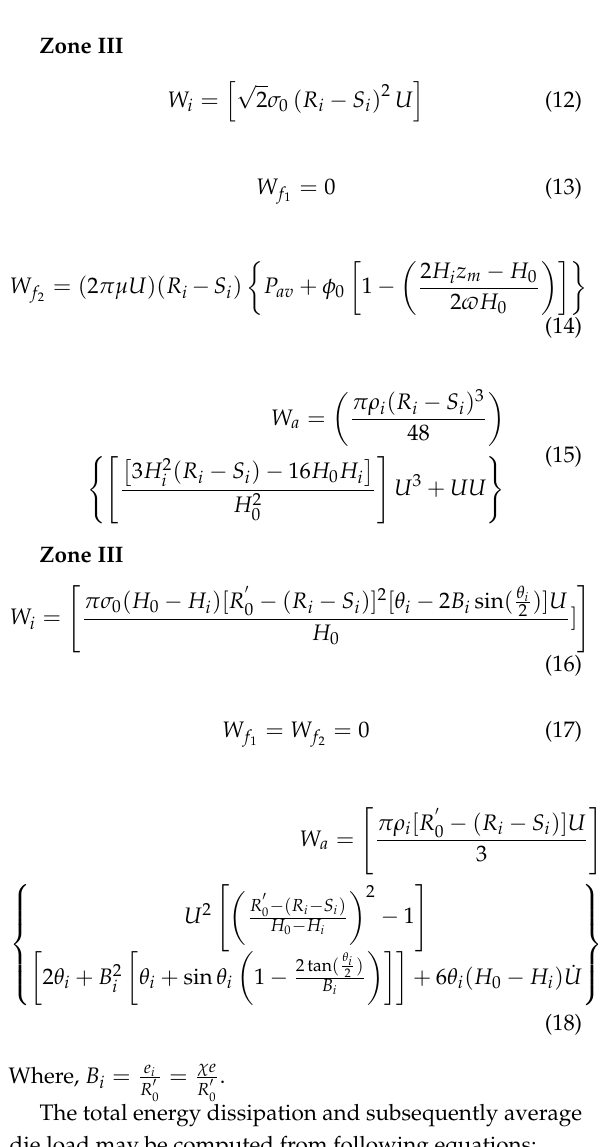
Fig. 6. Division of Prefrom